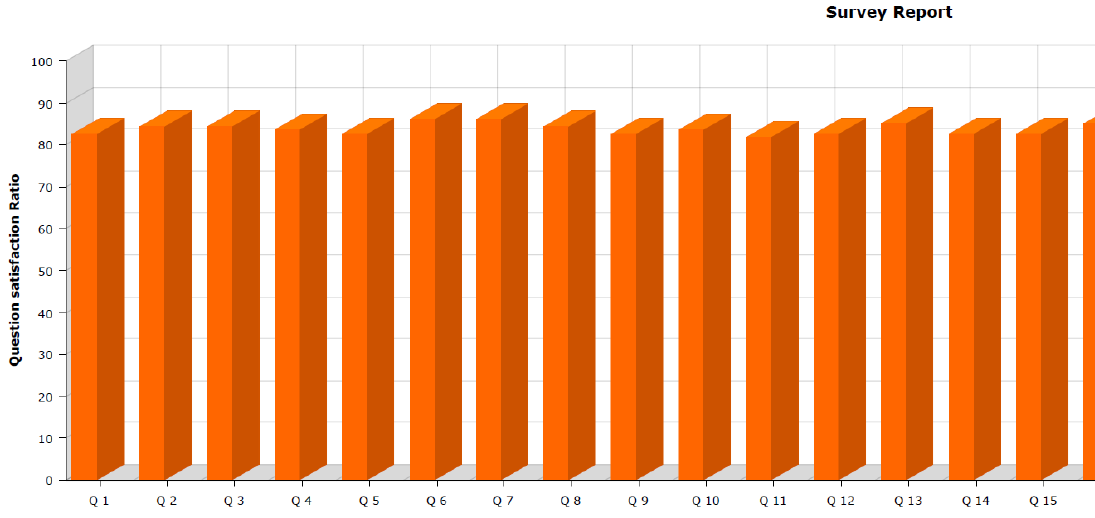
Figure 10. Percentages of graduates respond to their e ff ectiveness in solving real cases in the Figure 11. Percentages of graduates respond to their effectiveness in solving real cases in the Processes 2020 , 8 , x FOR PEER REVIEW manufacturing system. manufacturing system.